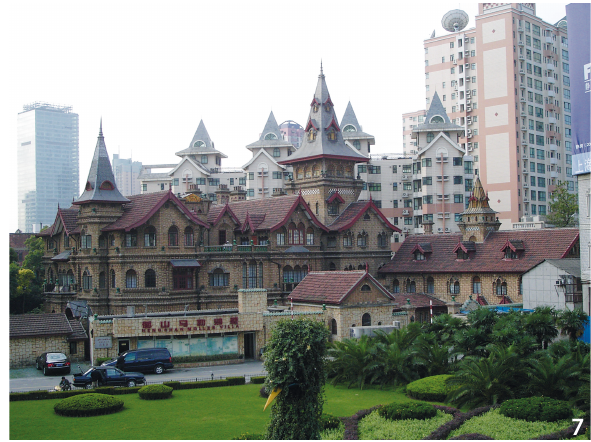
Figure 7 The Moller House and new buildings (Source: the author).